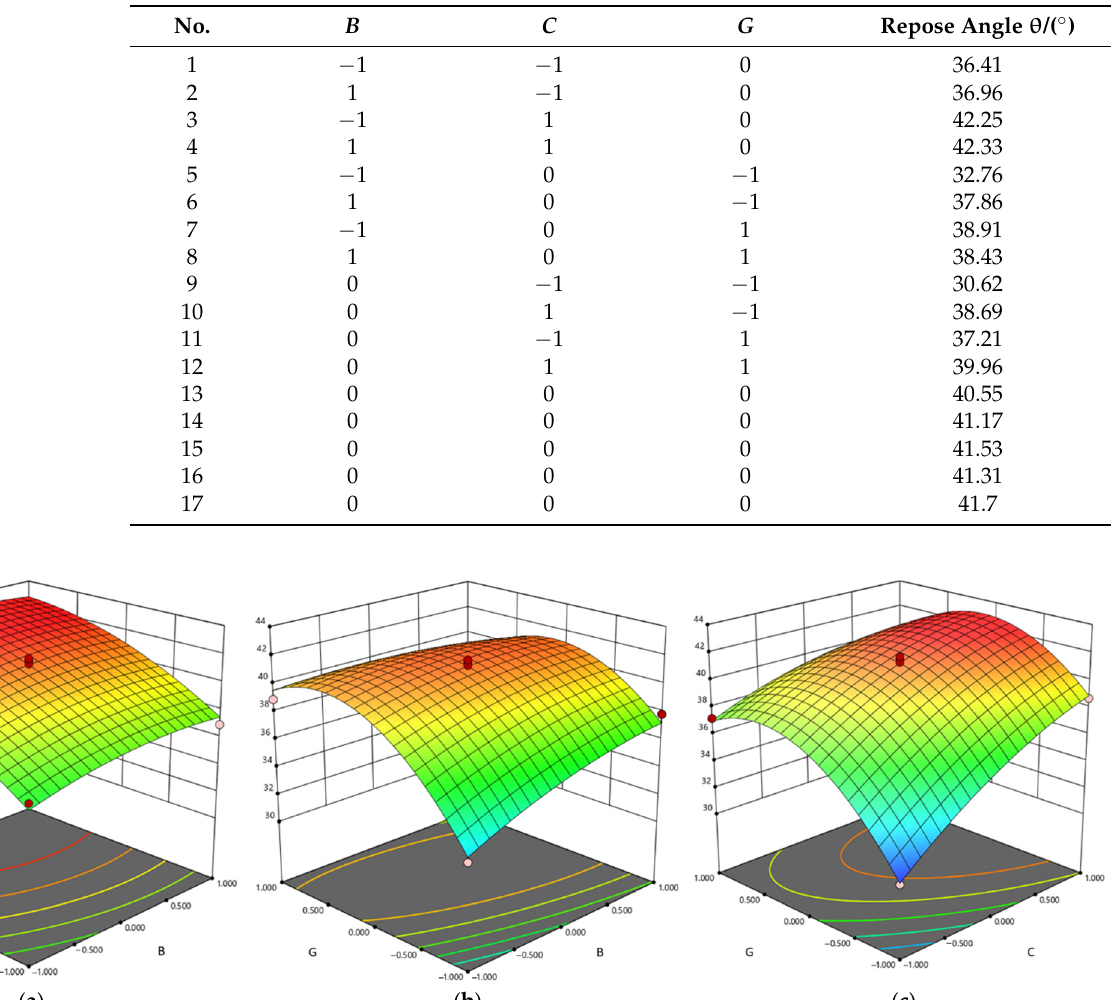
Table 10. Box–Behnken test regression model analysis of variance. Source